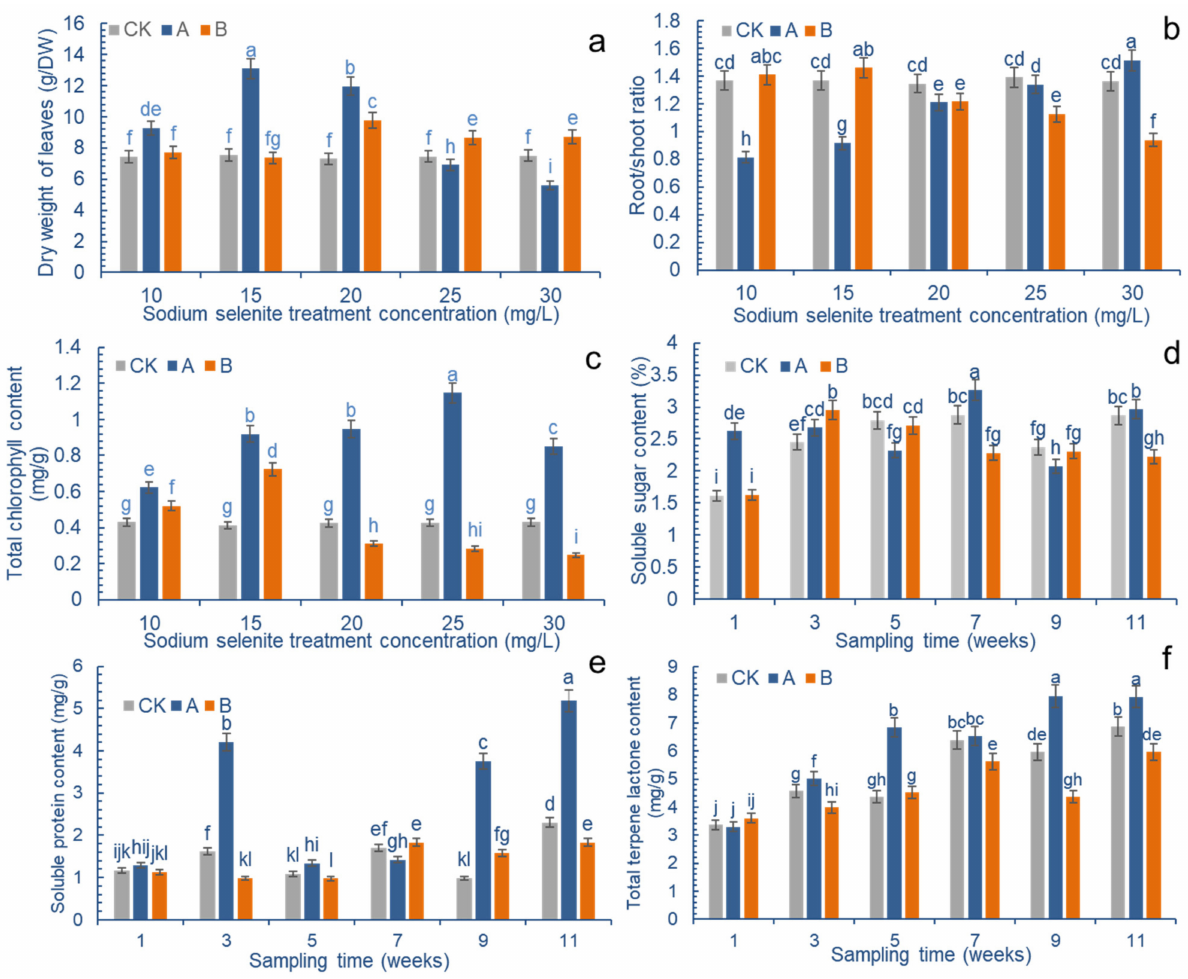
Figure 2. Effects of Na 2 SeO 3 on the physiological indexes and total terpene lactone content in Ginkgo leaves. Na 2 SeO 3 was prepared in 10, 15, 20, 25, 30 mg/L aqueous solutions, and treated with foliar spraying (group A) and root irrigation (group B). Tween 80, at 0.01%, was added to the sodium selenite solution that was sprayed on the foliar, and the control group (group CK) was replaced with distilled water. Regarding the Na 2 SeO 3 solution, 20 mg/L was used for foliar spraying (group A) and root irrigation (group B), for the same treatment, and samples were taken every two weeks to determine the changes in soluble sugar, soluble protein, and terpene lactone content. The lowercase letters a–l on the bar reflects the 5% significant level. ( a ) Total biomass of the treated ginkgo leaves; ( b ) the root to shoot ratio; ( c ) change in total chlorophyll content in leaves; ( d ) changes in soluble sugar content; ( e ) changes in soluble protein content; and ( f ) change in total terpene lactone